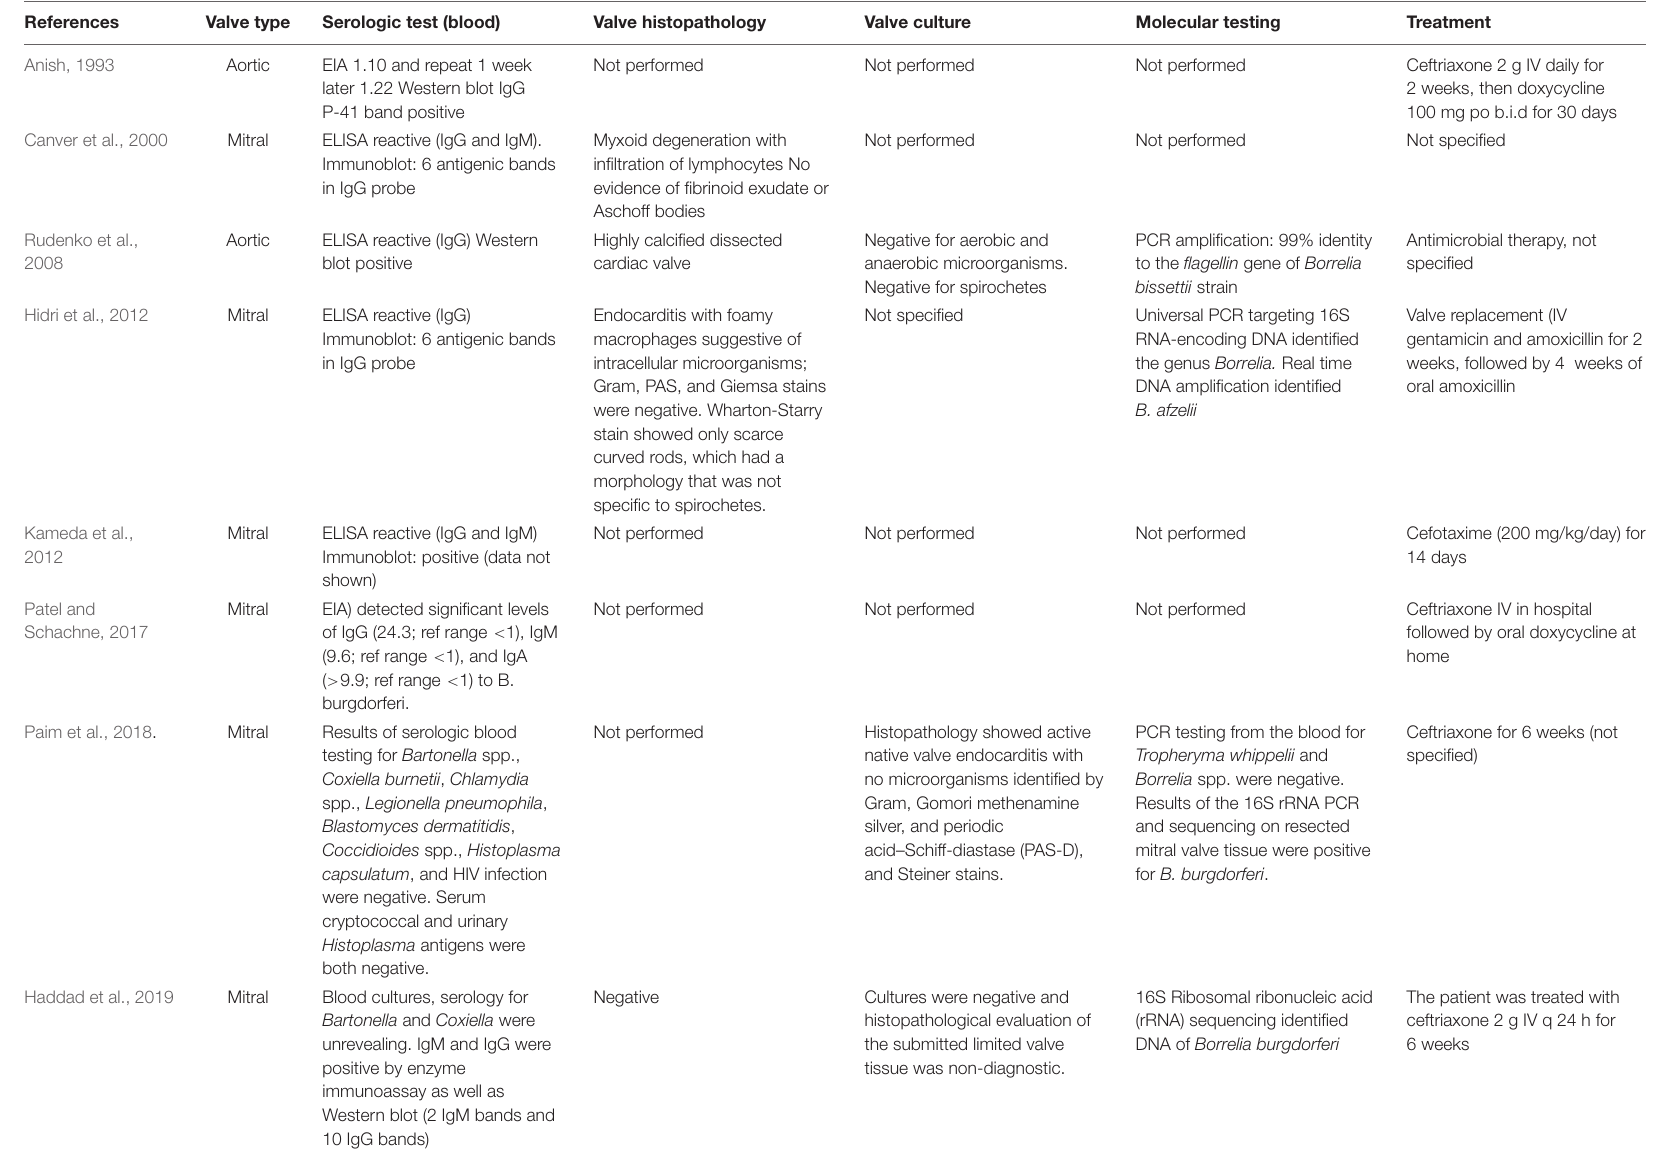
TABLE 1 | Summary of Case Reports of Lyme